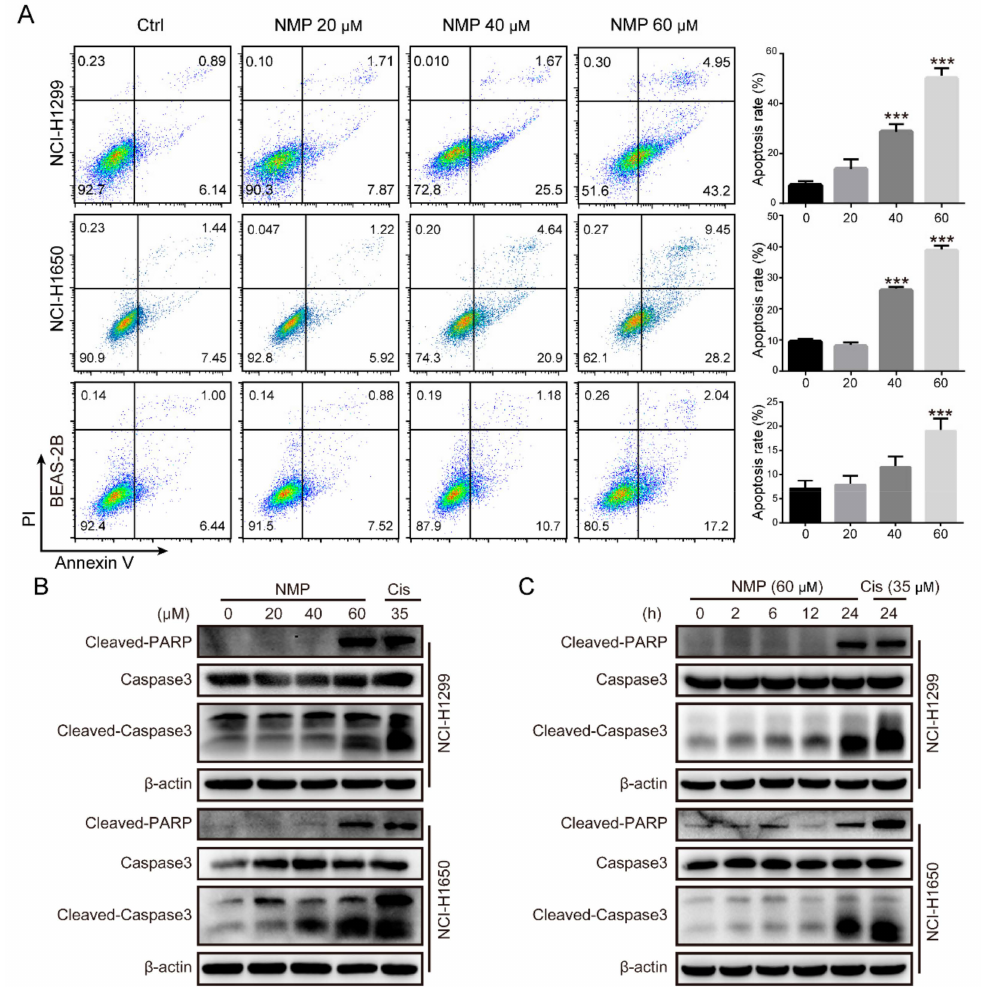
Figure 2. NMP induced apoptosis in NSCLC cells. ( A ) Flow cytometry analyses of NMP-treated NCI-H1299, NCI-H1650, and BEAS-2B cells that were subjected to PI / Annexin V staining assay for apoptosis detection. Error bars means ± S.D. of three independent experiments; *** p < 0.001, compared to the control group. ( B , C ) Western blots of whole cell lysates in NCI-H1299 and NCI-H1650 cells which were treated with NMP (60 µ M) or cisplatin(Cis, 35 µ M) at the indicated doses for 24 h ( B ) or for the indicated time courses ( C